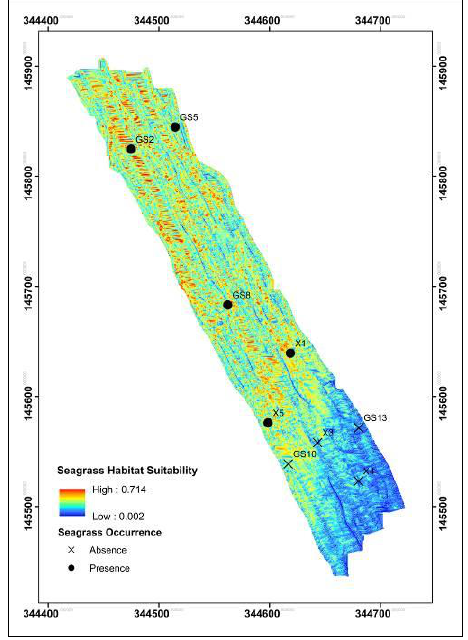
Figure 5. Seagrass habitat suitability model produced by MaxEnt model.